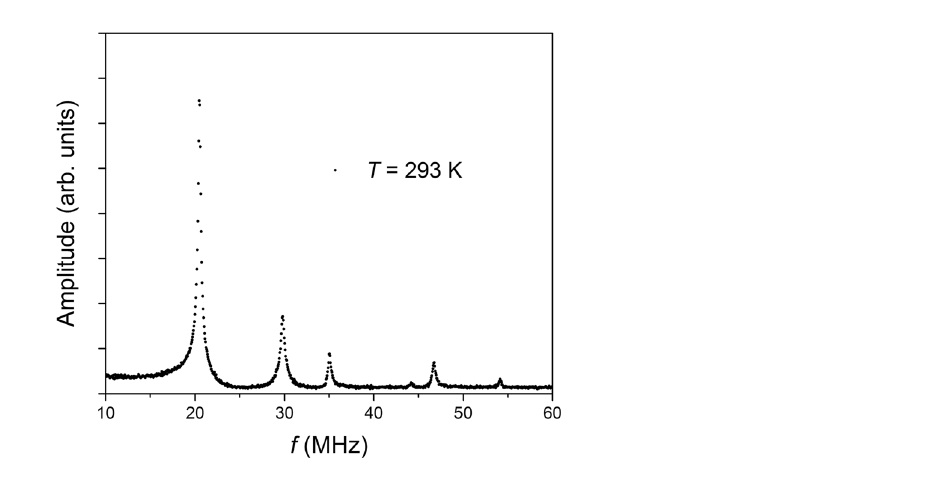
Figure 2. Room temperature mechanical resonance spectrum. Amplitude as a function of frequency, f , for the 17-nm-thick MoS 2 resonator showing the fundamental mode ( f ~ 21.8 MHz) and higher-order